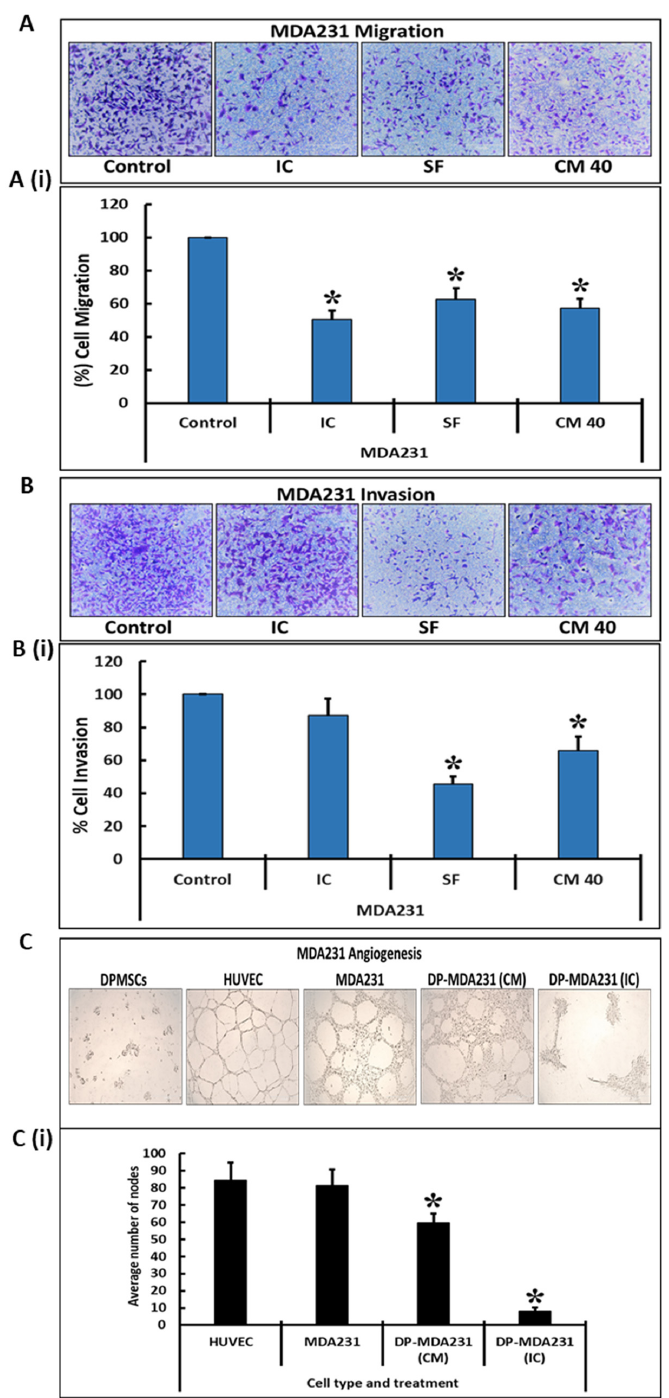
Figure 3. Effect of DPMSCs on MDA231 cell functions: The migration of MDA231 cells after treatment with DPMSCs in IC and SF settings, and after treatment with 40% CM, by a transwell assay. Treated MDA231 cells with DPMSCs in IC and SF settings, as well with 40% CM of DPMSCs, migrated at a significant slower rate through the 8 µM pore of a transwell filter as compared to the untreated control cells. Panel ( A ) shows the photomicrographs of the migrated cells under various